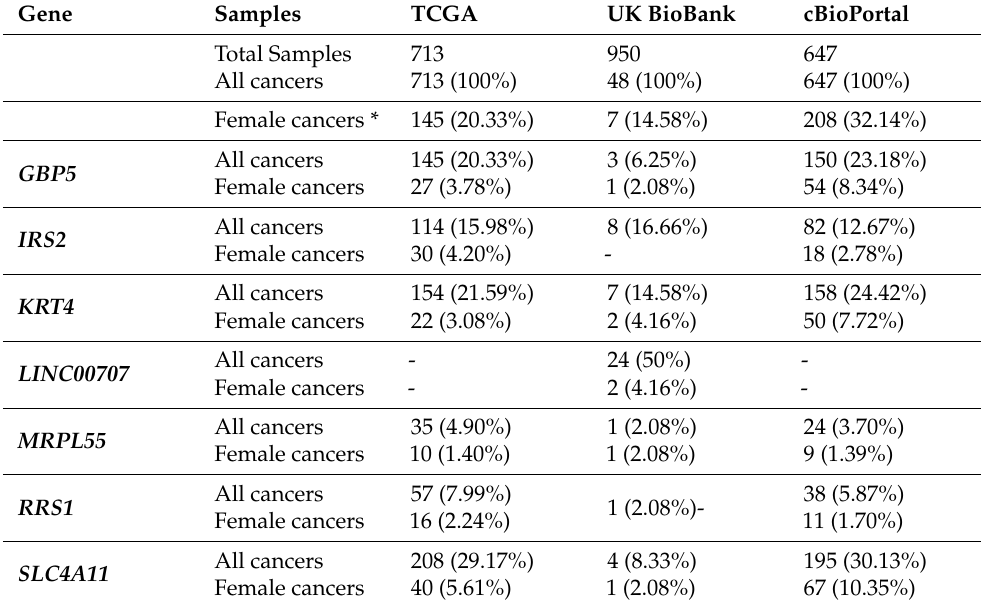
Table 1. Data summary for the mutation samples from TCGA, UK BioBank and cBioPortal datasets. The “Total Samples” is with respect to the samples associated with the genes of interest.